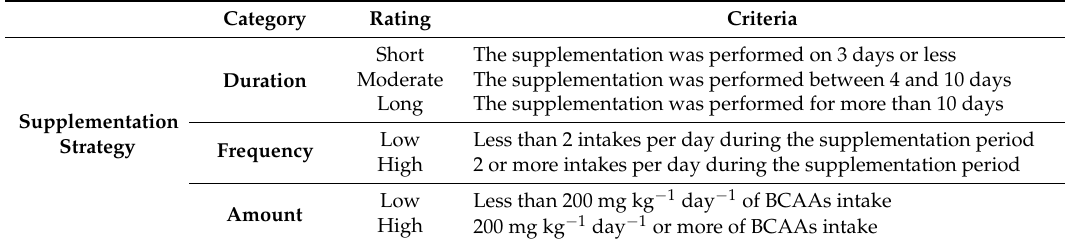
Table 1. Rating criteria concerning the supplementation strategy (i.e., duration, frequency and amount of daily BCAAs intake) and the extent of muscle damage assessed from changes in indirect markers of muscular alterations in the control